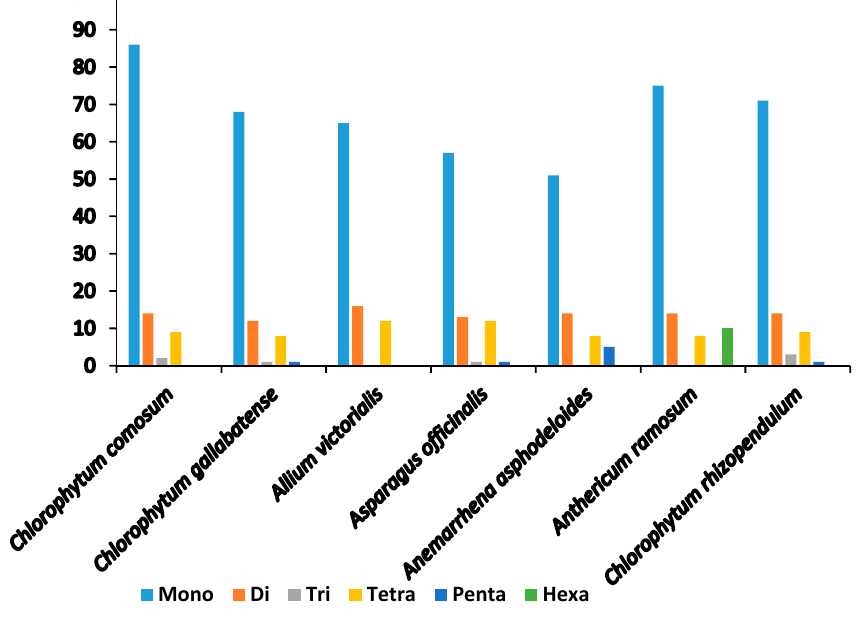
Figure 3. Number of different types of SSRs. Numbers of simple sequence repeats (SSRs) in the C. comosum and C. gallabatense chloroplast